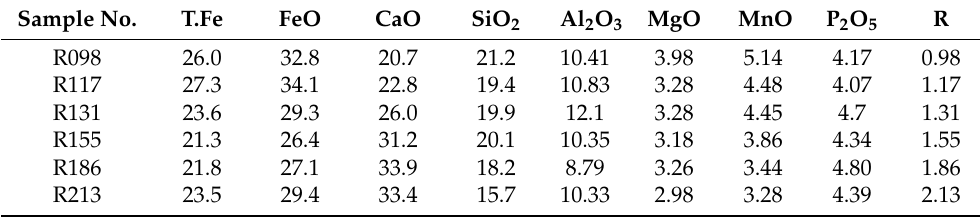
Table 3. Compositions of oxides in the dephosphorization slag (mass%). Sample